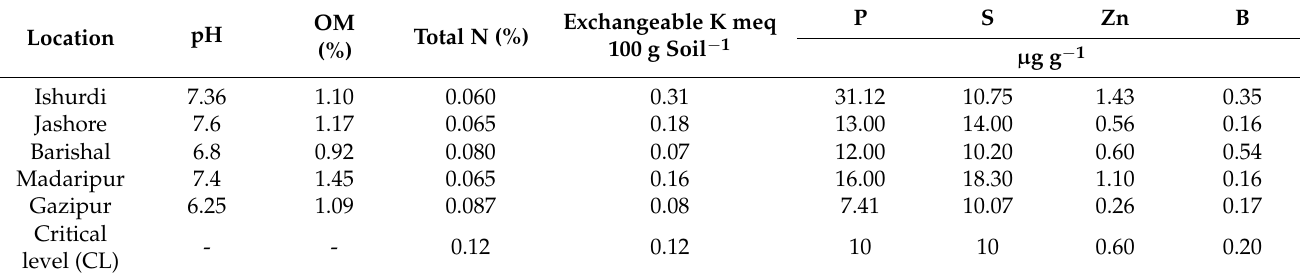
Table 3. Chemical properties of initial soil sample (0–15 cm soil depth) of the five experimental sites.